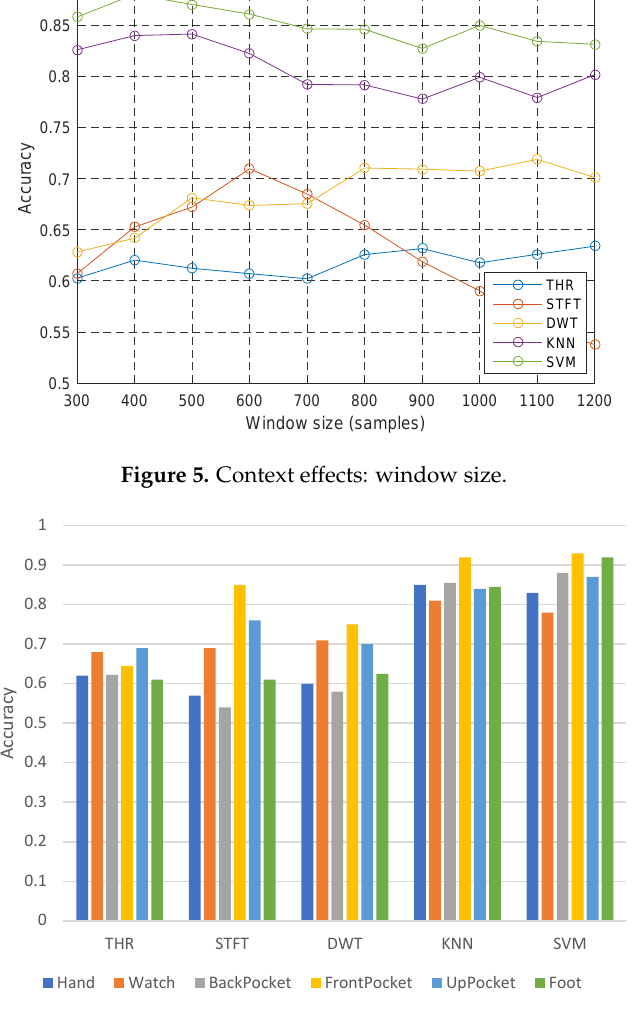
Figure 6. Context effects: